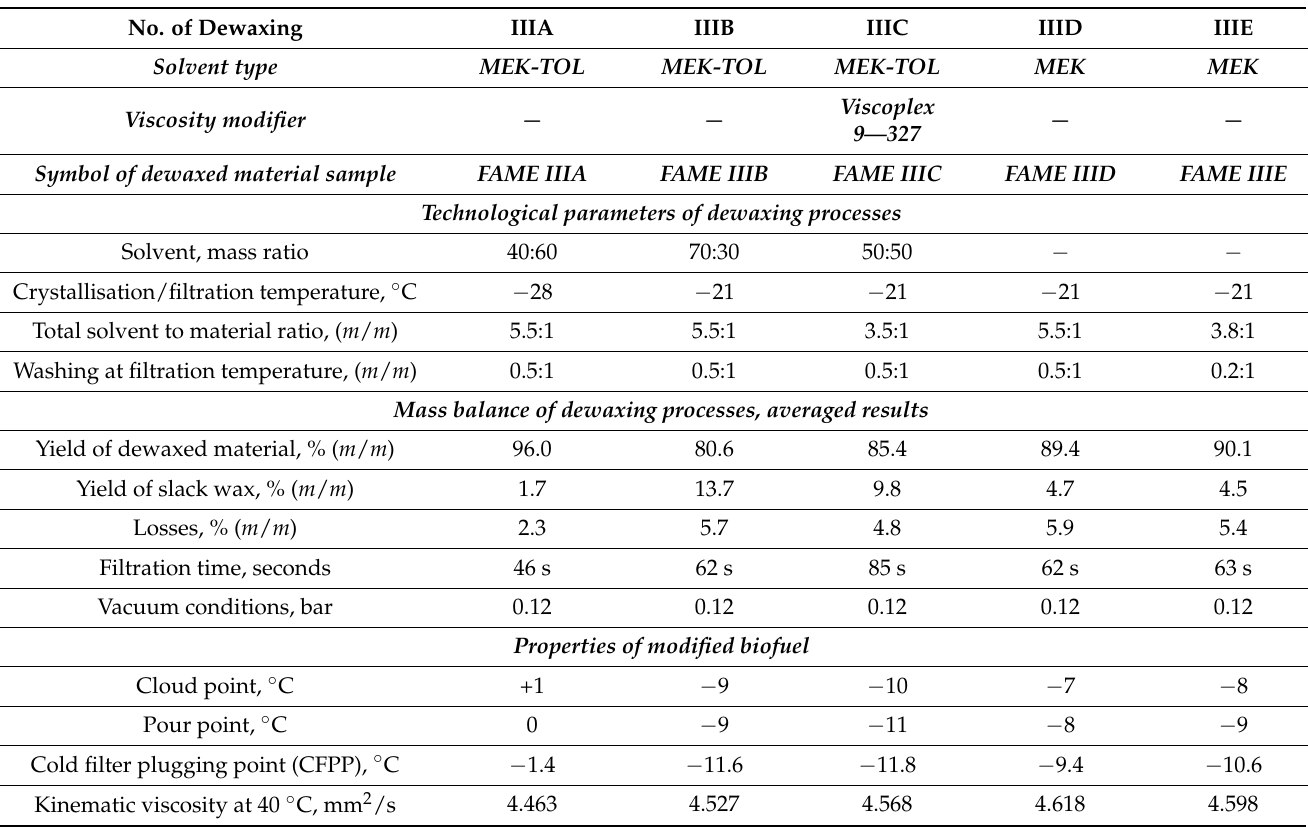
Table 4. Technological parameters and the mass balance of carried out tests, and properties of modified biofuels, when the FAME III was used as a raw